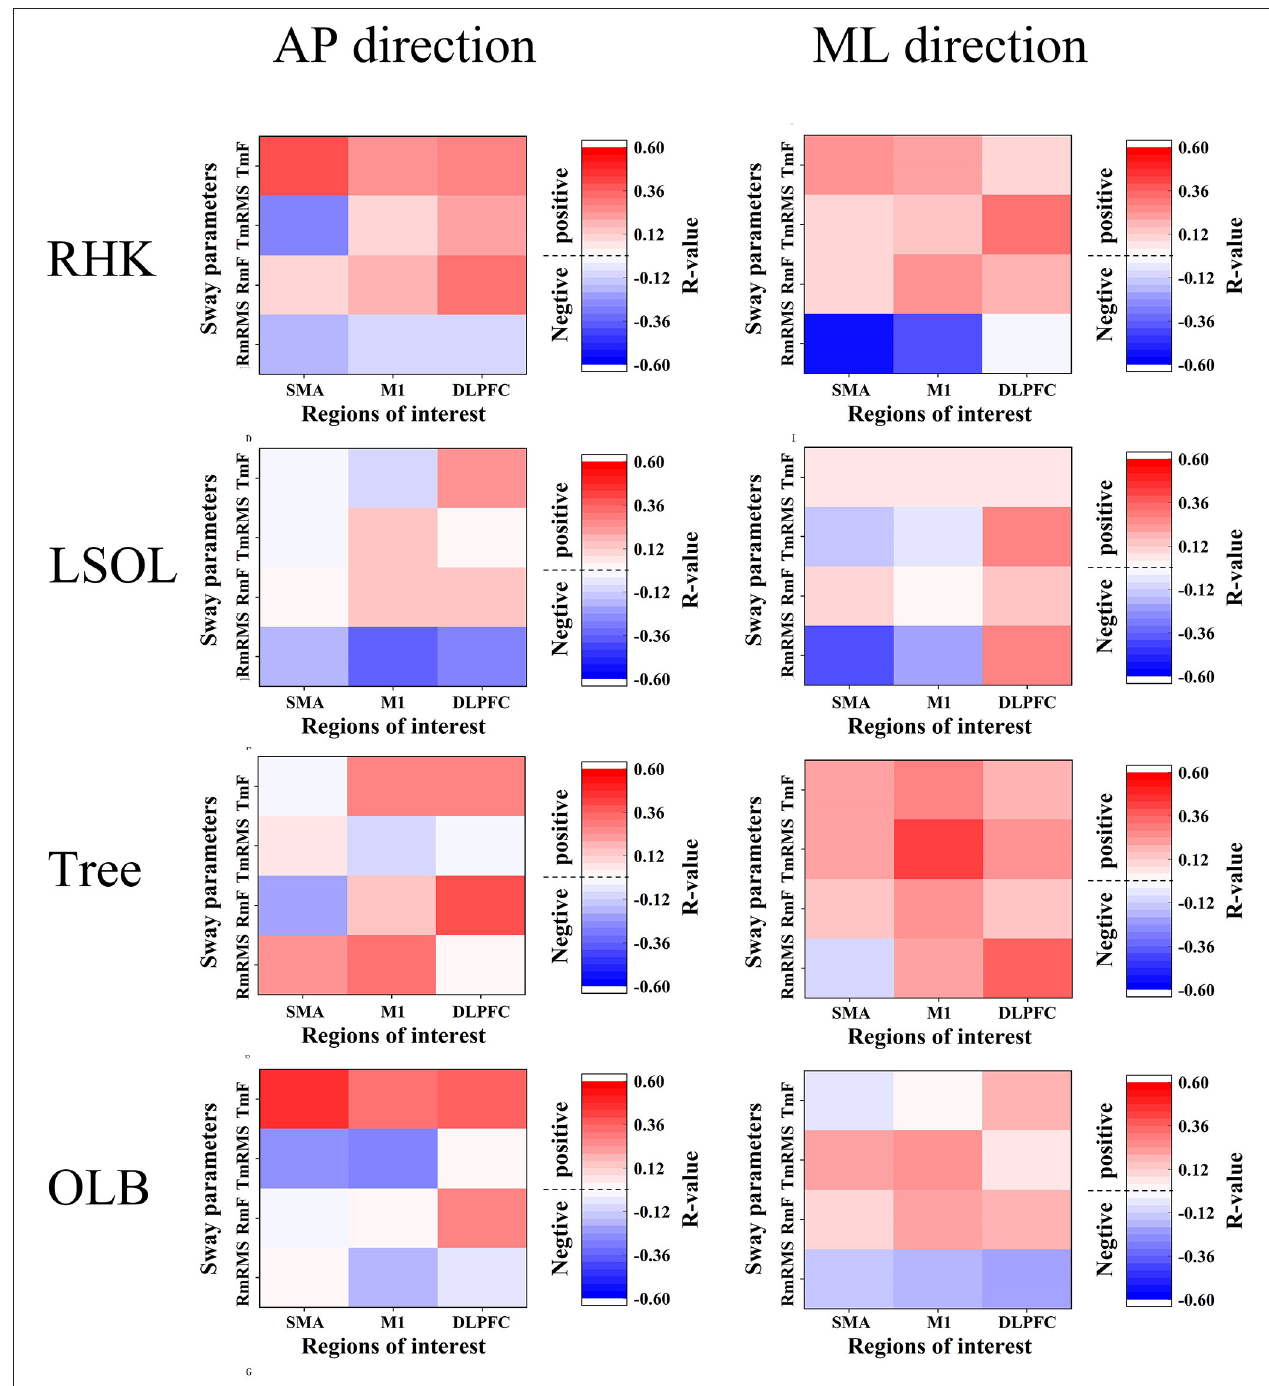
FIGURE 6 | Correlations between sway parameters and brain activation. RHK, right heel kick; LSOL, left lower body and stand on one leg; OLB, one-leg balance; SMA, supplementary motor area; M1, primary motor cortex; DLPFC, dorsolateral prefrontal cortex; Rm RMS , root mean square of rambling; Tm RMS , root mean square of trembling; Rm F , mean power frequency of rambling; Tm F , mean power frequency of trembling.